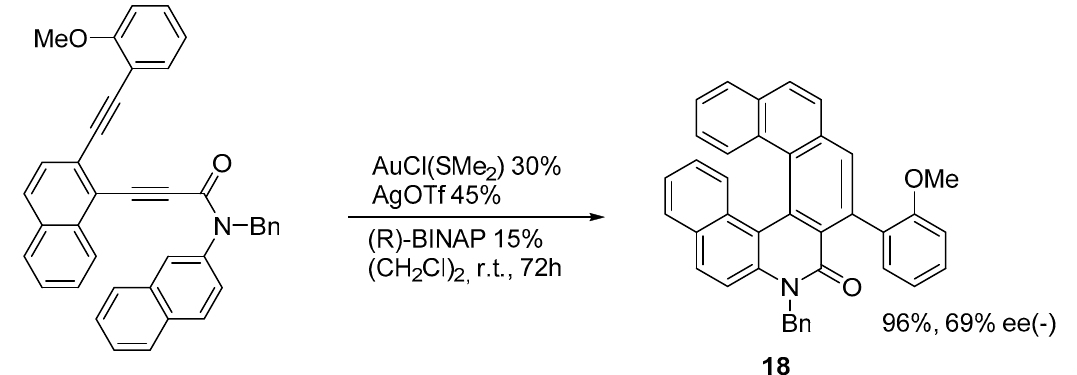
Scheme 12. Preparation of a substituted 7-aza[6]helicenone.